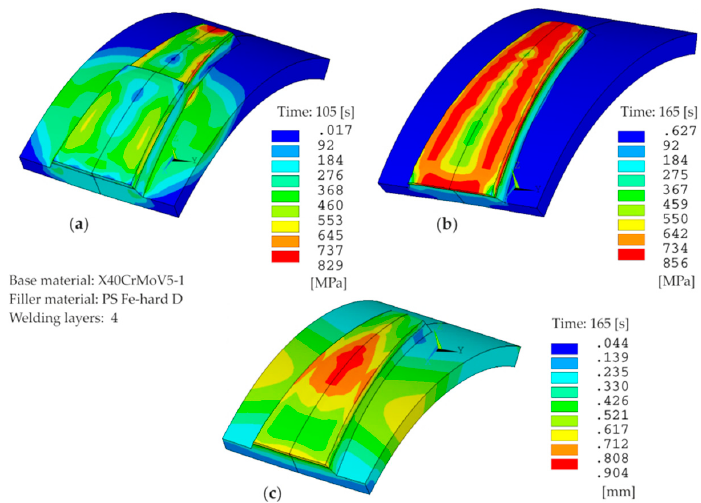
Figure 7. Simulation results: ( a ) comparative stress according to Van Mises during the thermal deposition second hard layer; ( b ) comparative stress according to Von Mises after complete component cooling; and ( c ) deformation perpendicular to the component plane after complete component